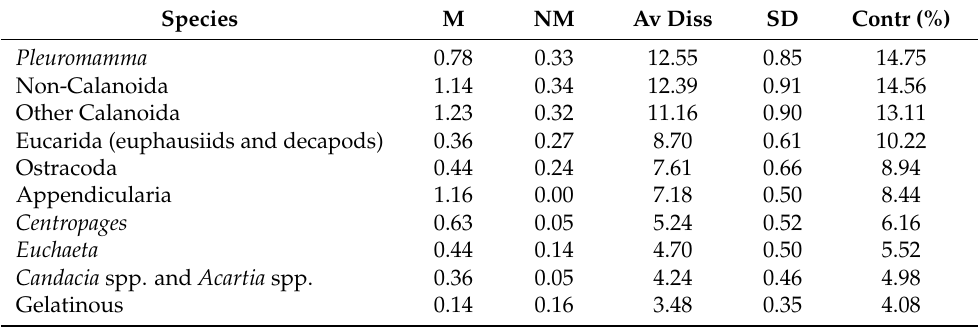
Table 5. Main contribution of prey categories to the dissimilarity between the diets of migrant and non-migrant mesopelagic fish (similarity percentage analysis, SIMPER). Values in the columns “M” and “NM” are average abundances of the migrant and non-migrant groups, respectively; Av Diss: average dissimilarity; SD: Standard deviation; and Contr: percentage of prey contribution to diet